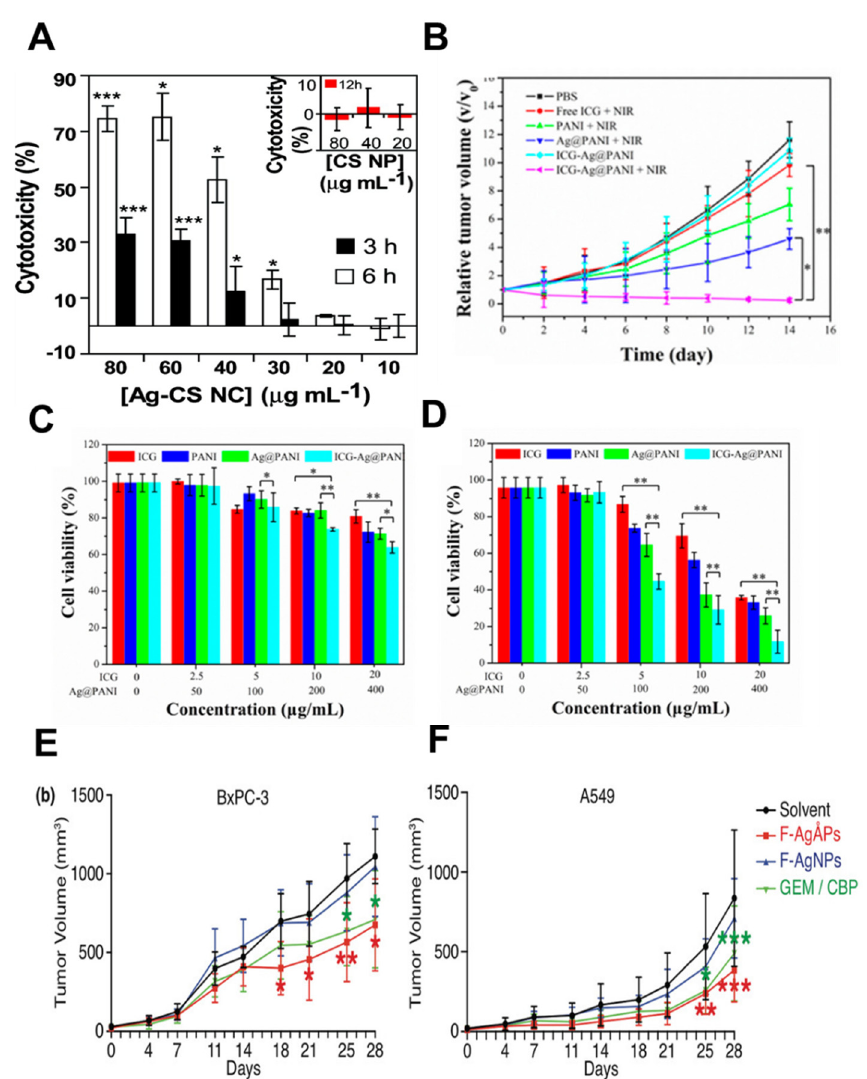
Figure 3. ( A ) The cytotoxicity comparison of AgNPs-chitosan nanocarrier (Ag-CS NCs) on HT29 cells, as calculated from the LDH assay. The cytotoxicity of CS NPs treatment is shown in the inset. Reprinted with permission from Reference [26], Copyright 2011 American Chemical Society. ( B ) The comparison of ani-tumor e ff ects from mice carrying tumor-infused HeLa cells with di ff erent concentrations, monitored with and without NIR laser irradiation (808 nm, 1.0 W cm 2 ). Cell viability in HeLa cells was